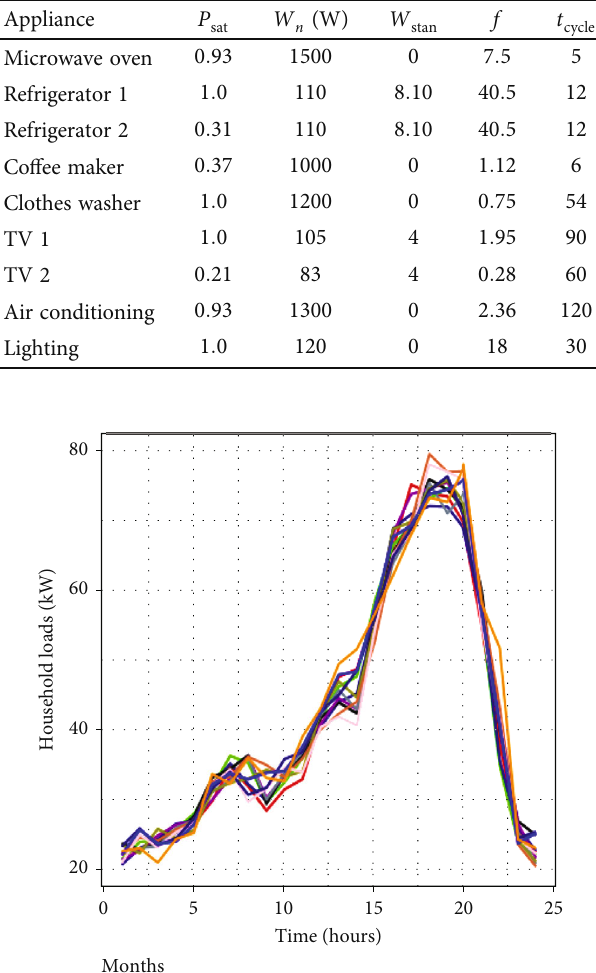
Table 3: Household appliance